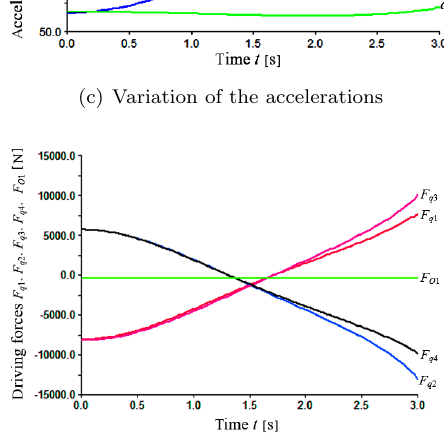
Figure 8: The kinematics and dynamics results of the GHMT obtained from ADAMS